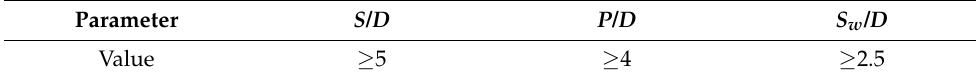
Figure 3. Typical joint configurations: ( a ) holes arranged in one row; ( b ) holes arranged in two rows with parallel form; ( c ) holes arranged in two rows with staggered form. Table 4. Geometrical parameters specified for composite joints